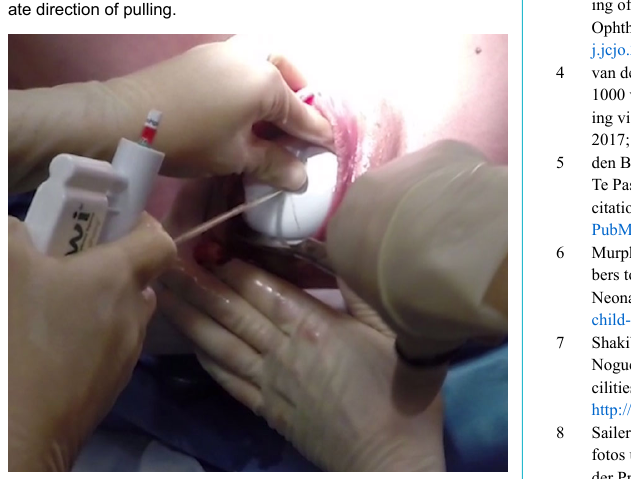
Figure 3: Wrong handling of episiotomy scissors and inappropri- ate direction of pulling.